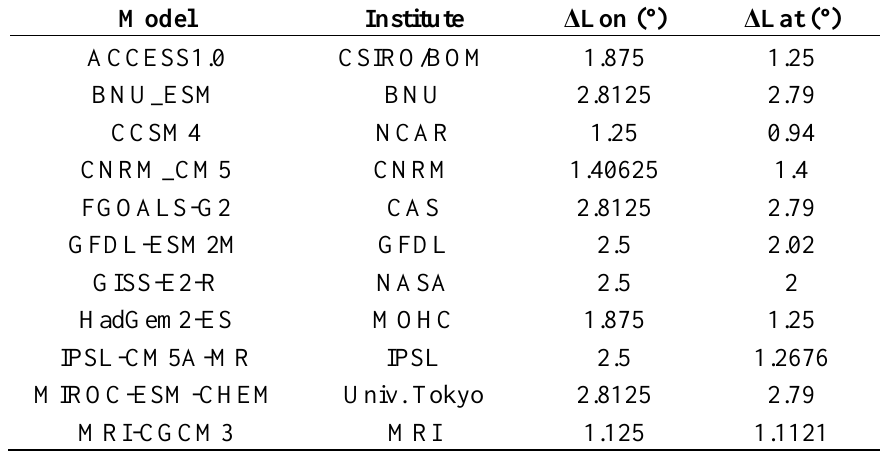
Table 3. List of global climate models (GCMs) used to drive the UrbClim